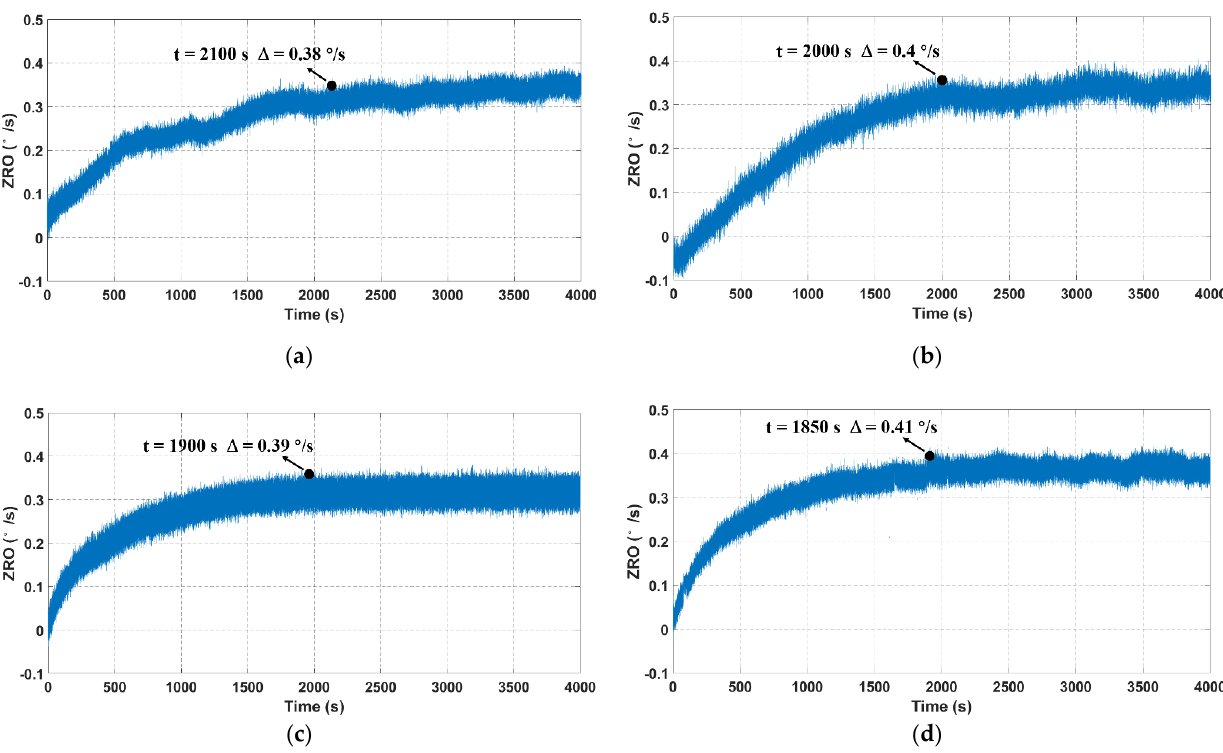
Figure 6. ZRO result comparisons between four TFGs at a sampling rate of 1 kHz. ( a – d ) represent the ZRO of samples 1–4, respectively. Table 1. The duration and magnitude of ZRO drifts for four